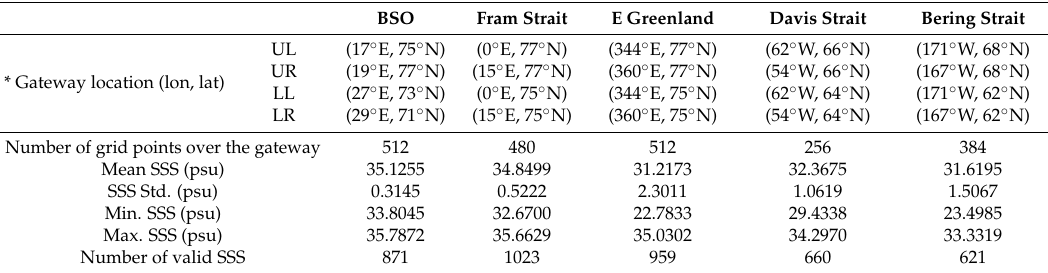
Table 3. List of the mean, standard deviation, minimum and maximum values of SMAP SSS retrieved at the Arctic Gateways from 1 May 2015 to 30 April 2018.